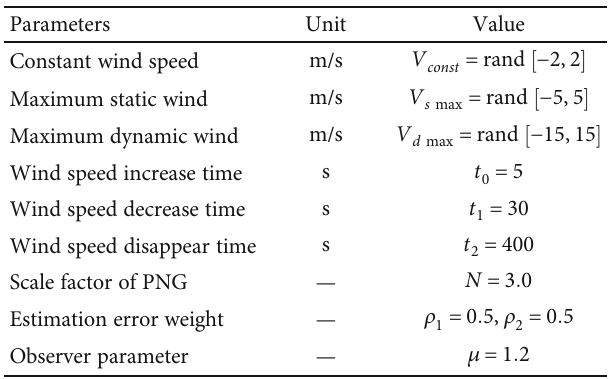
Table 2: Basic parameters.